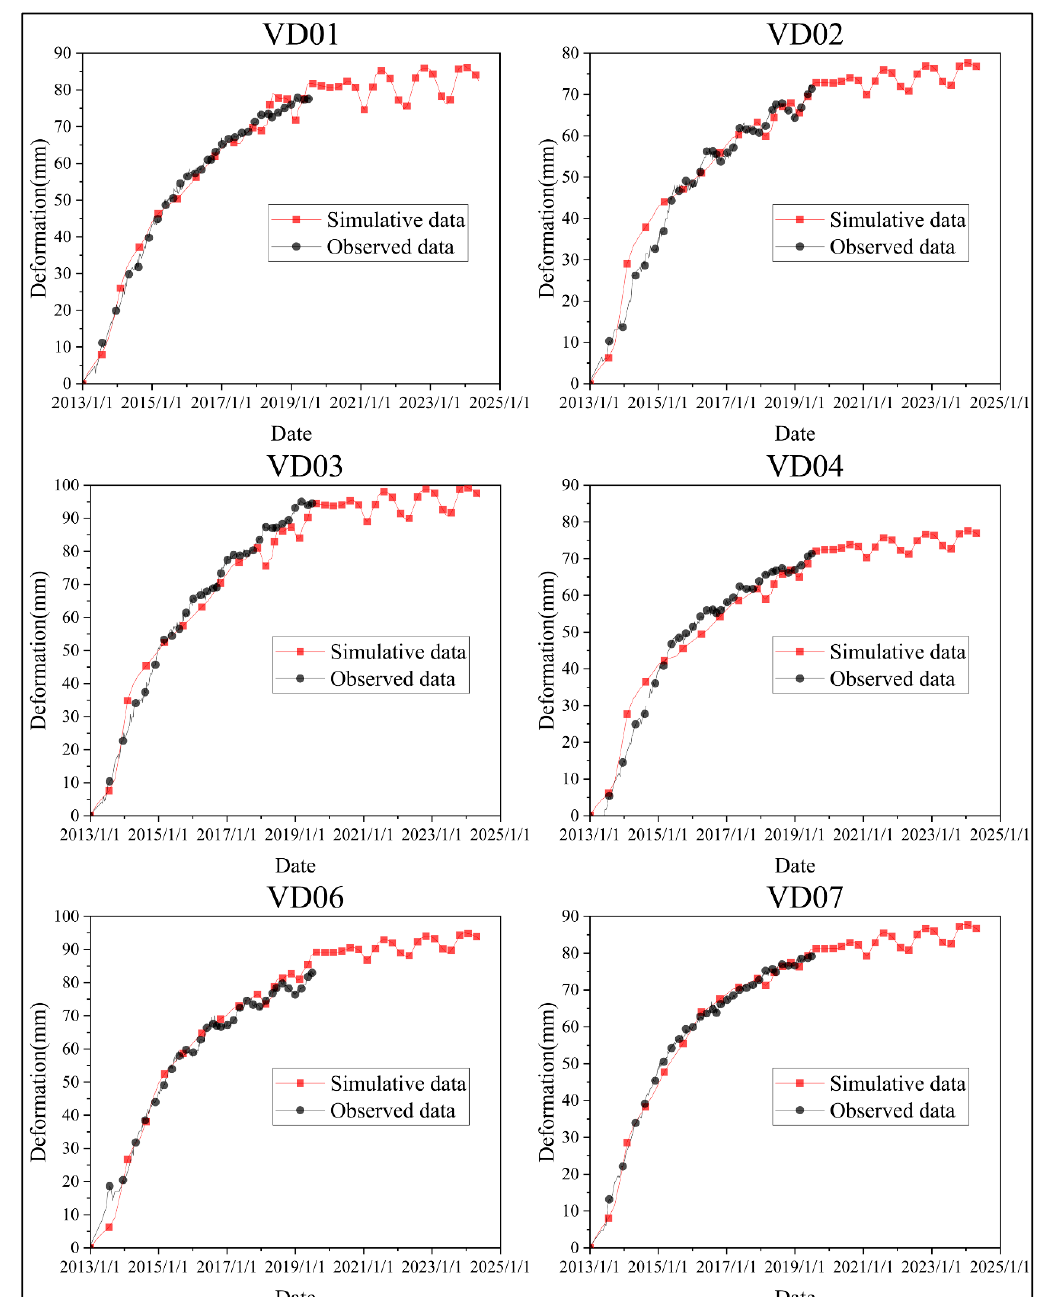
Figure 19. Comparison between simulation data and observed data.